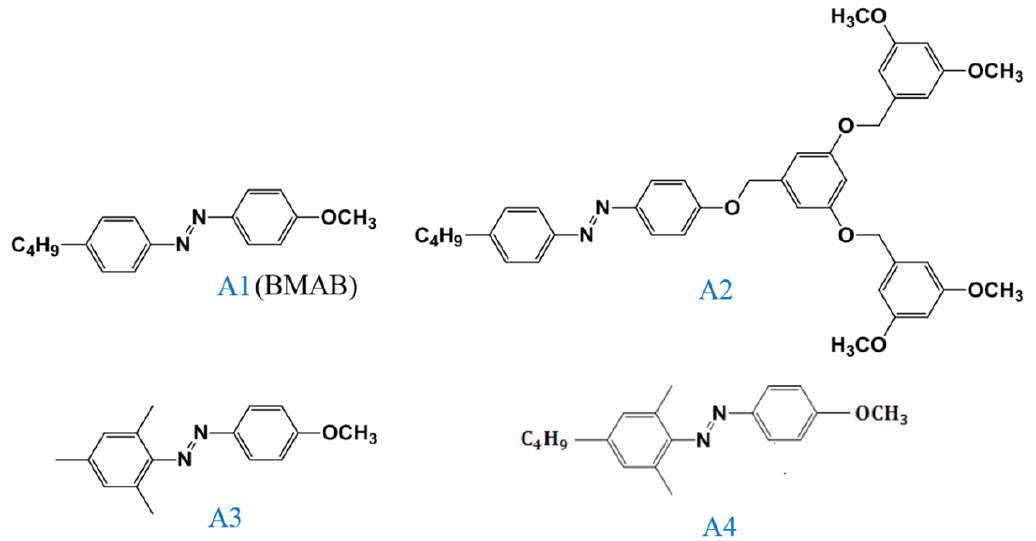
Figure 13. Structures of the LC-like Azo derivatives and their abbreviations.